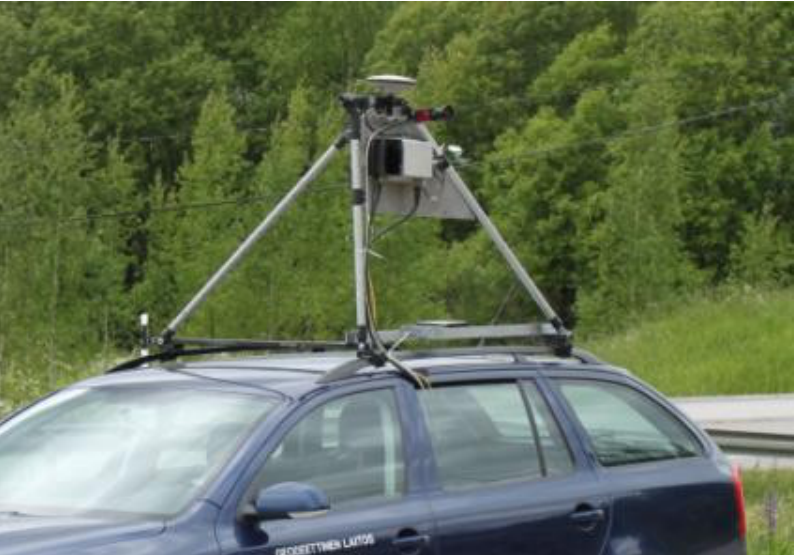
Figure 12. The Sensei mounted on the roof of a car.